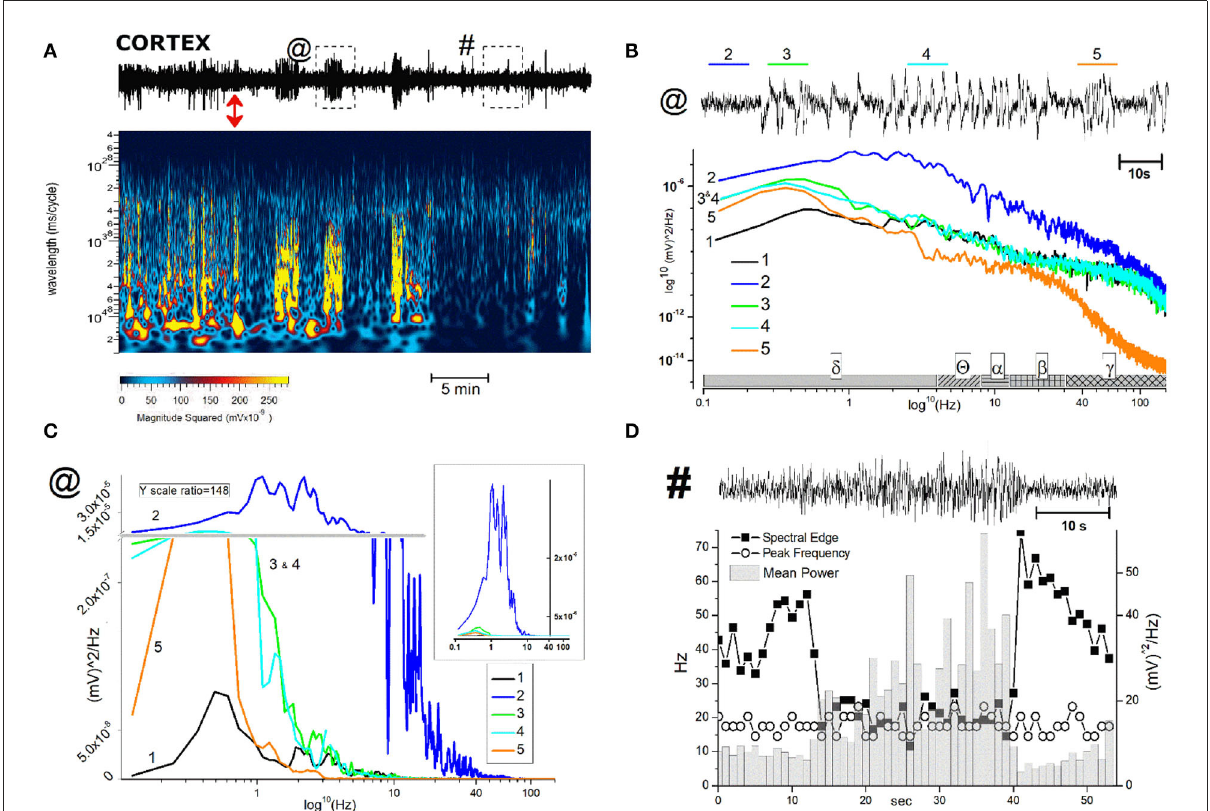
FIGURE7 Description and analysis of unusual cortical EEG events after JWH-073 administration. (A) , Top: representative 40min EEG recorded from somatosensory area, before and after JWH-073 administration (marked with a red double headed arrow). Framed areas in EEG, labeled with “@” and “#” and analyzed in detail in panel (B,C) (for @) and (D) (for #), are EEG traits showing relevant difference respect to control. (A) (center): Spectrogram of above EEG. (B) EEG area “@” of panel (A) is replayed on the top at a faster time scale. Tracts labeled from 2 to 5 (named in text as “complex”), mark altered electrical activity different each other and from control (referred as 1, not shown in EEG). (B) (middle): power spectrum analysis of 1–5. The X axis has a scheme bar referring to EEG bands. (C) Same plot of (B) adopting linear Y scale; Y broken (horizontal gray line), marks different scale ratio (1/148 of the bottom scale) adopted to constrain all plots in a limited ordinate. (B) Inset: Same figure but without the Y axis break. (D) (top): EEG area “#” of panel (A) is replayed on the top at a faster time scale. Left Y axis (Hz) refers to “spectral edge” and “peak frequency”; right Y axis refers to “mean